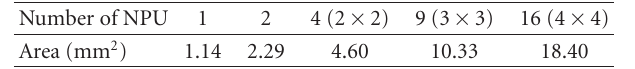
Table 2: Area scalability results.